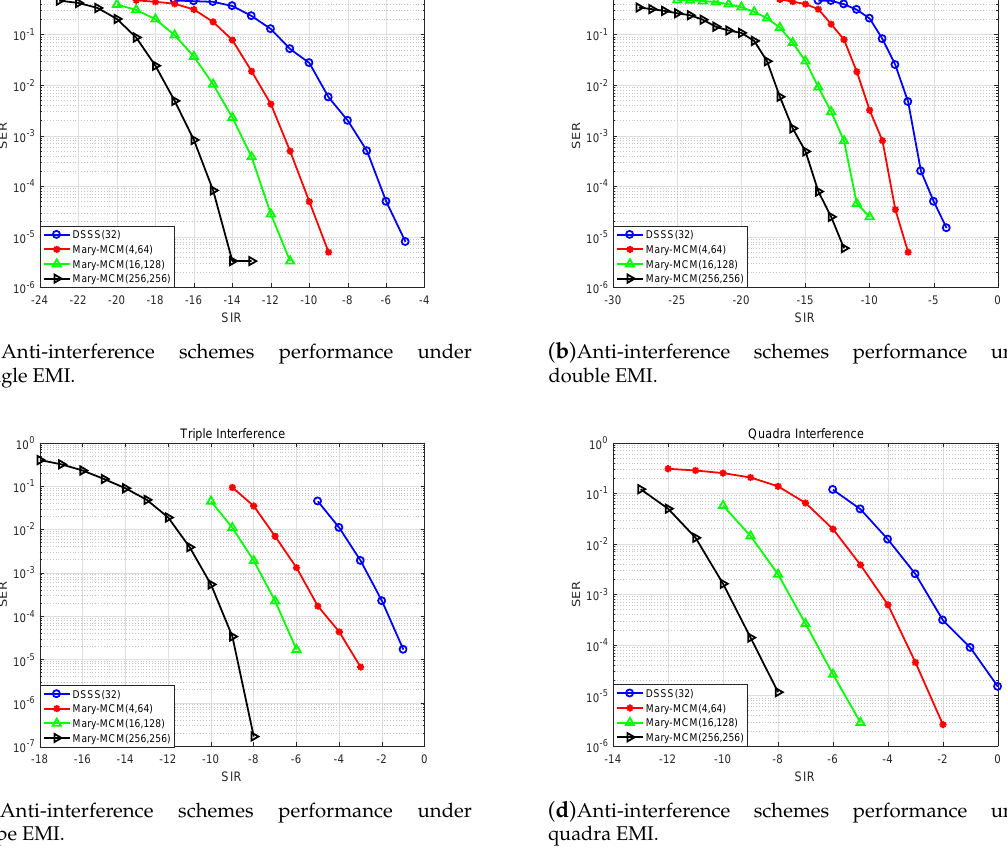
Figure 19. Anti-interference scheme performance under different